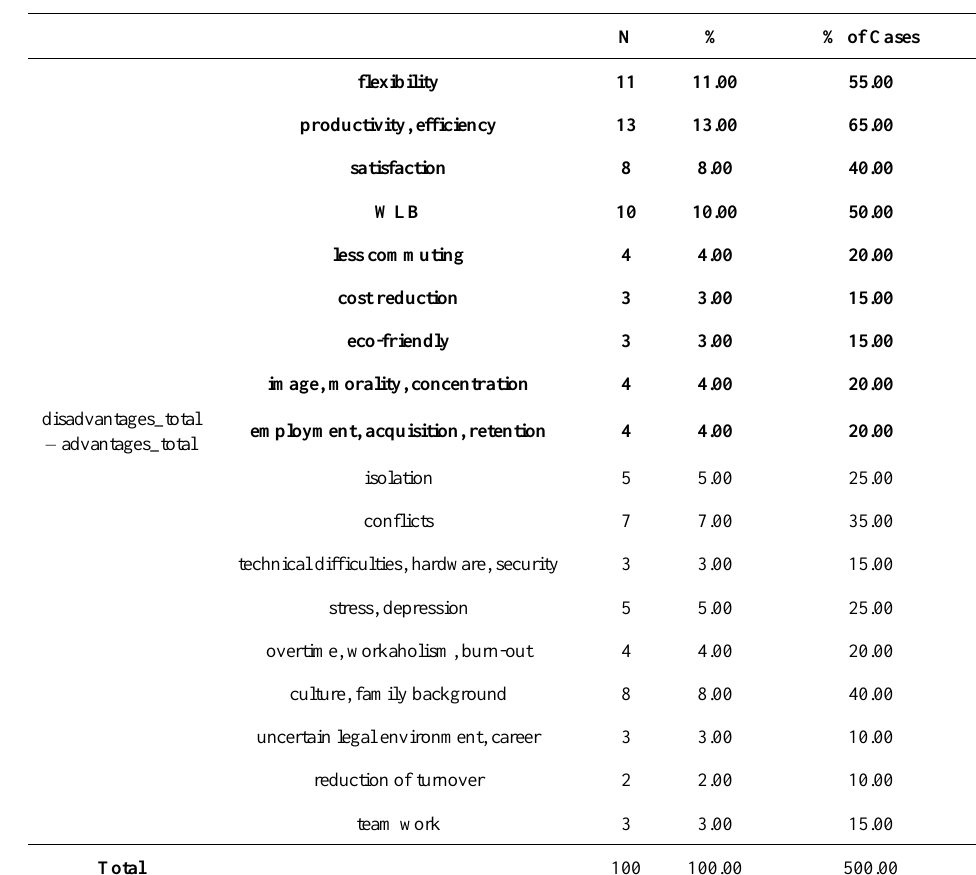
Table 5. Advantages and disadvantages,